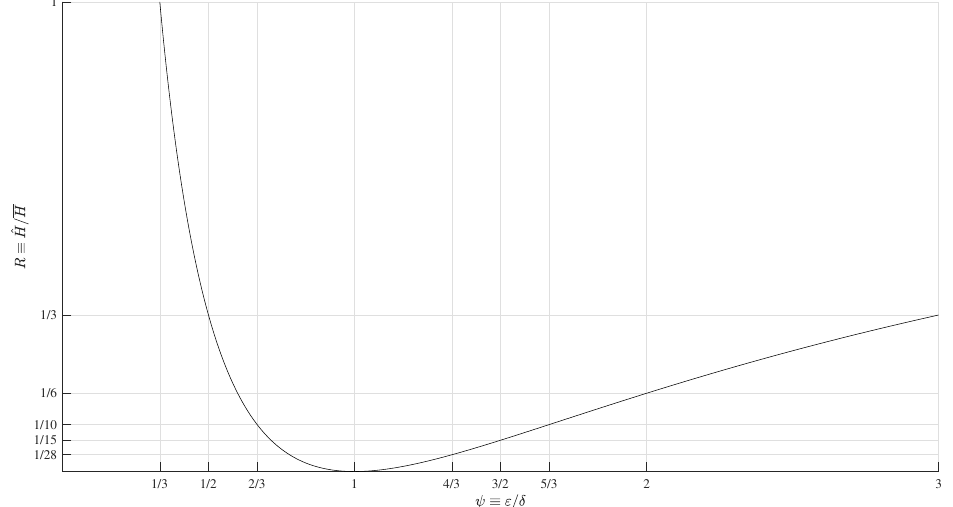
Figure 9. Ratio of the total to the free energy of oscillations as a function of the ratio of forcing decay ε to free damping δ showing a minimum at ψ = 1 in agreement with Table